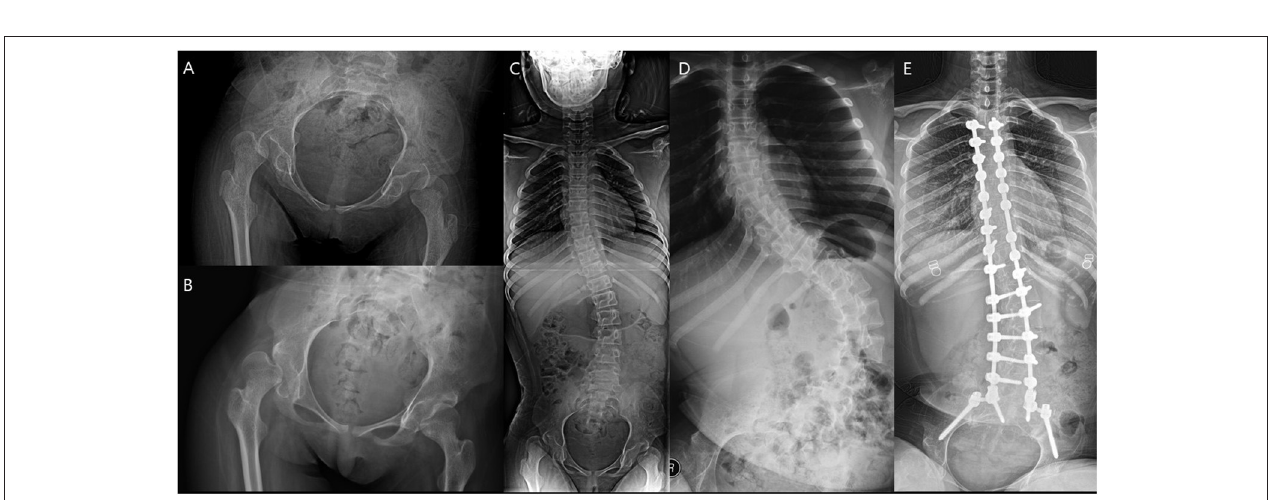
FIGURE 6 | A patient with newly developed scoliosis after surgery and stable hip status throughout. (A) Preoperative. (B) 1 year after the index operation. (C) 5 years after the index operation.